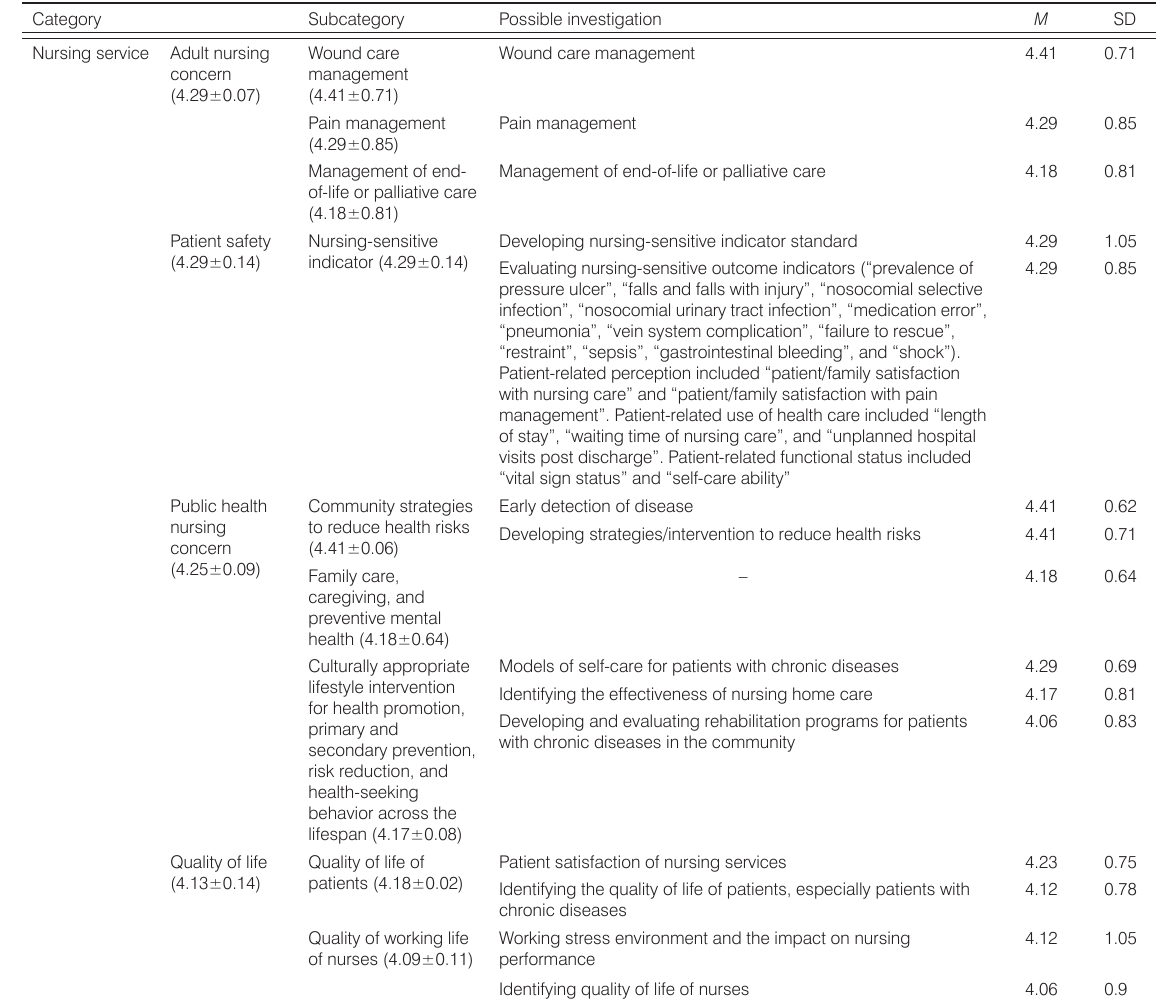
Table 2. Research topic priorities in